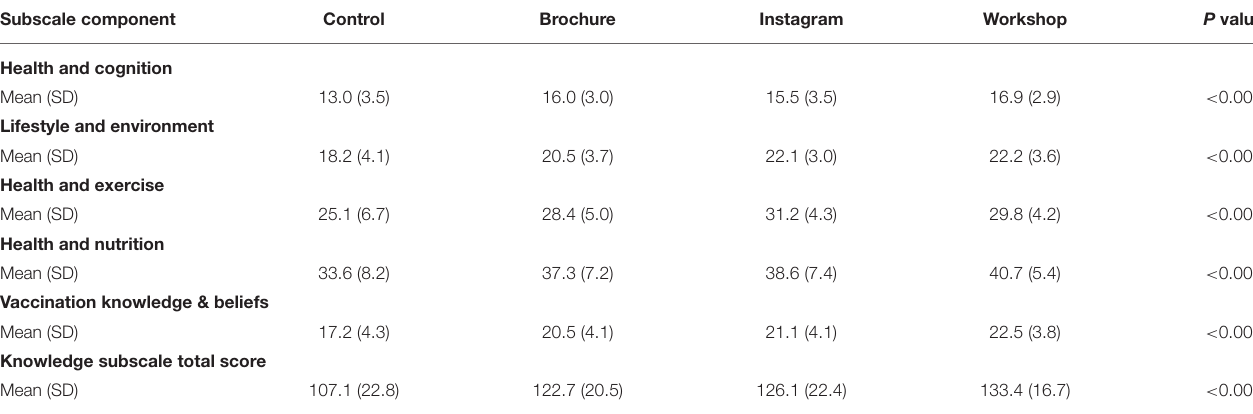
TABLE 4 | Participant’s knowledge subscale (between group).